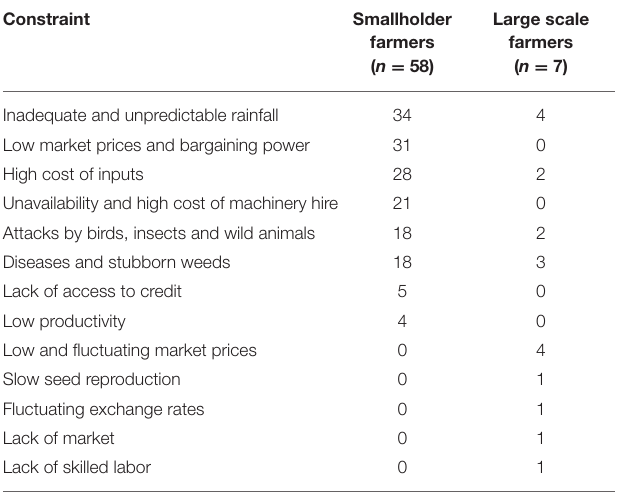
TABLE 3 | Gross margins for wheat farmers. TABLE 4 | Constraints to production identified by smallholder and large-scale wheat farmers.